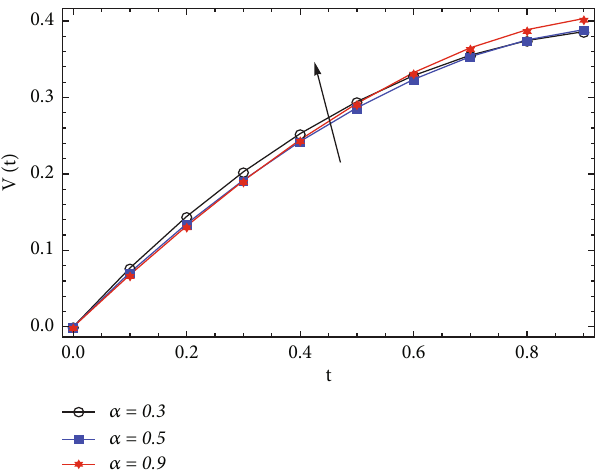
= 1and β Figure 7: In drainage case e ff ect of β on V ð x Þ where g p = 0 : 95 are fi xed.